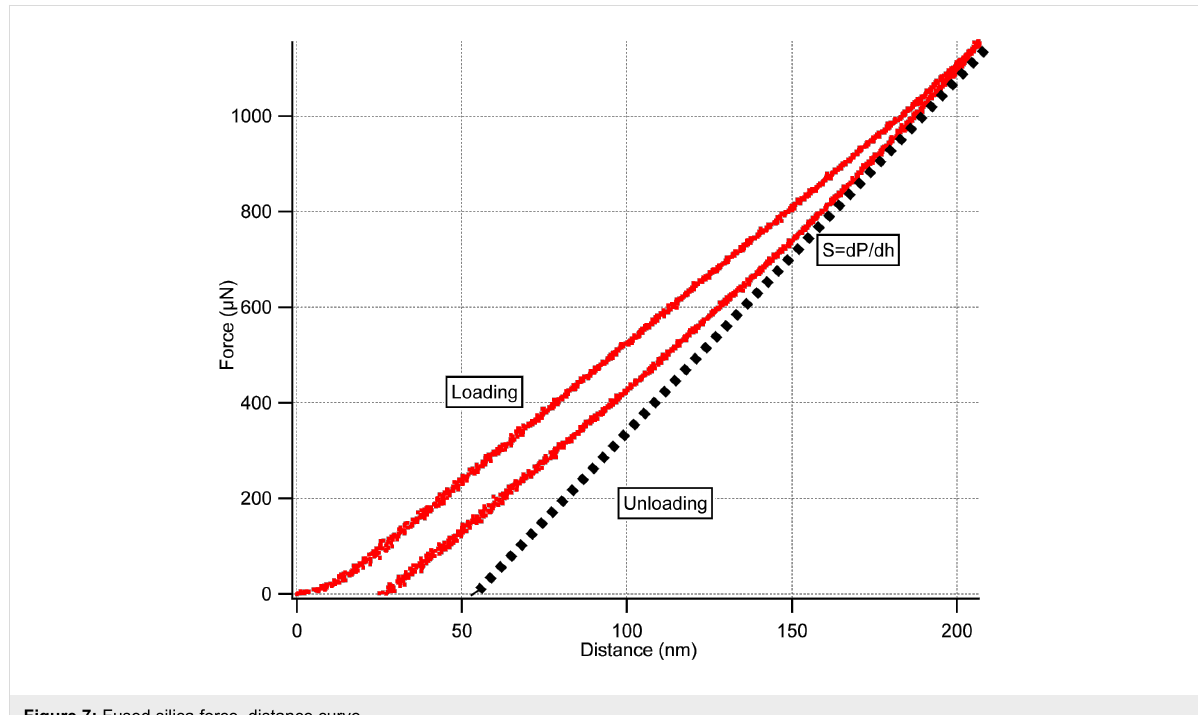
Figure 7: Fused silica force–distance curve.